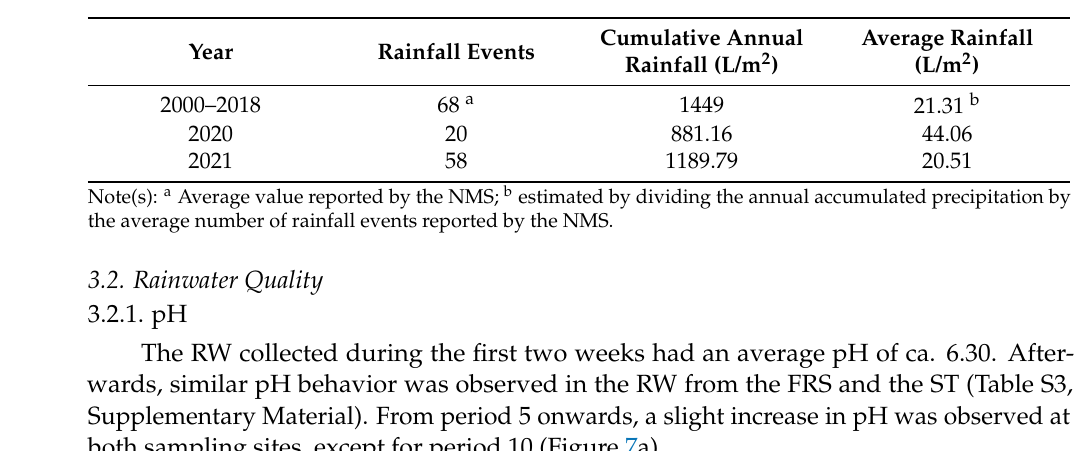
Table 1. Rainfall events per year.